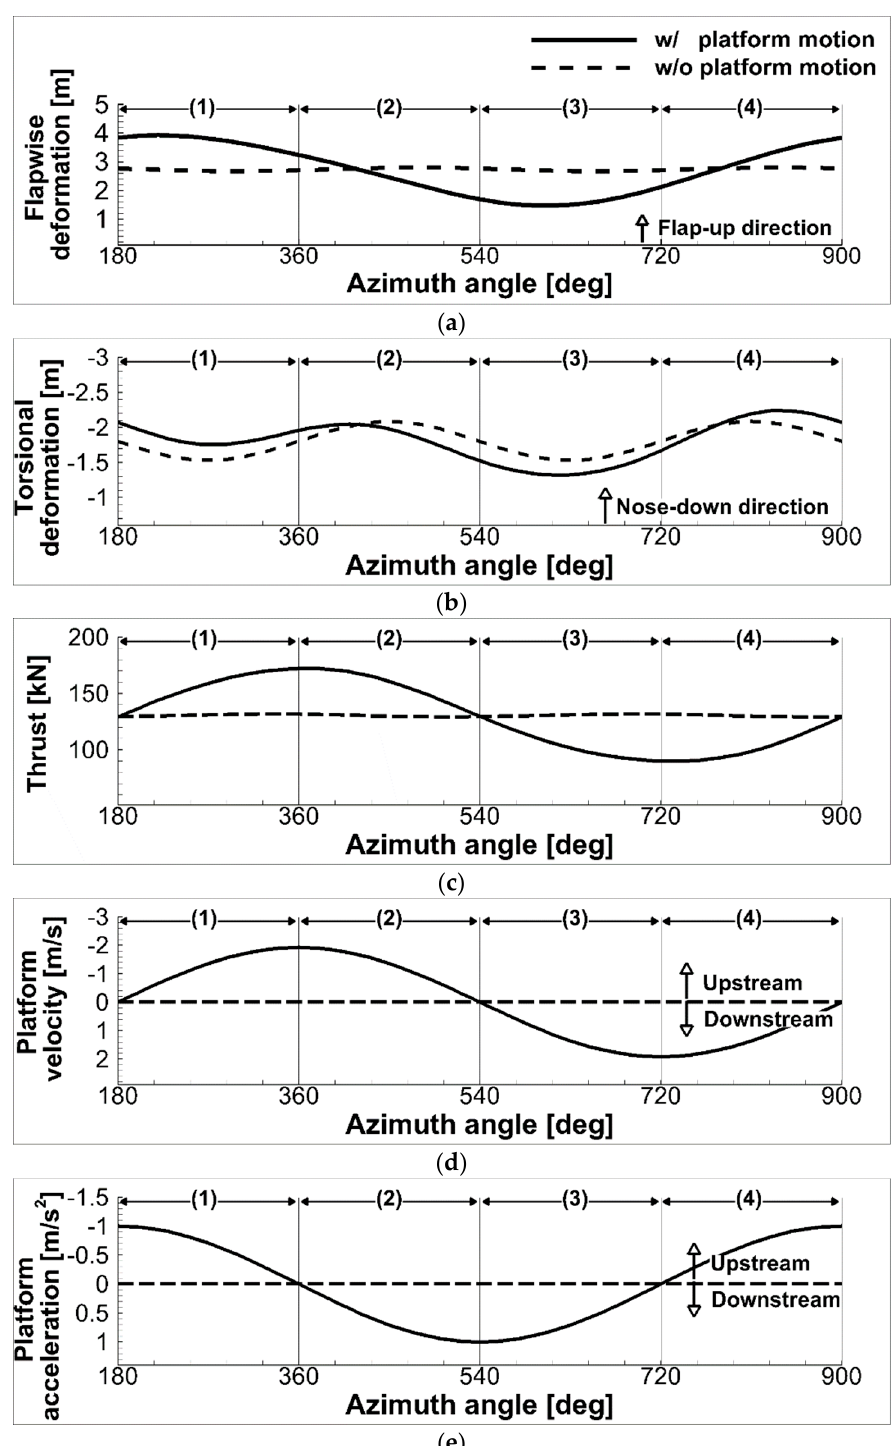
Figure 10. Blade tip deformations under translational platform motions. ( a ) Heave motion. ( b ) Sway motion. ( c ) Surge motion.